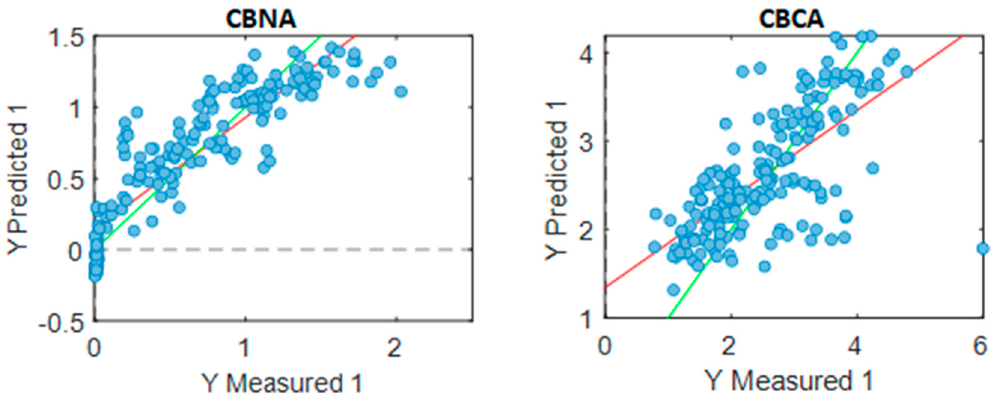
Figure 4. Plot of measured values versus the predicted values of cannabinoids in the validation dataset with data obtained from the Bruker MPA II instrument processed from the PLS_toolbox using the PLS-R tool. Cannabidiolic acid (CBDA), tetrahydrocannabinolic acid (THCA-A), cannabidiol (CBD), tetrahydrocannabinol (THC), cannabichromene (CBC), cannabinol (CBN), cannabidivaric acid (CBDVA), cannabidivarin (CBDV), cannabigerolic acid (CBGA), cannabigerol (CBG), tetrahy- drocannabidivarin (THCV), tetrahydrocannabidivarinic acid (THCVA), cannabinolic acid (CBNA) and cannabichromenic acid (CBCA). Units are expressed in mg/g. Green line: line of best fit from reference data; red line: line of best fit from predicted data. Table 3 . The different pre-processing methods applied to partial least squares regression models (PLS-R) for the determination of cannabinoid compounds using data from the Bruker MPA instru- ment.